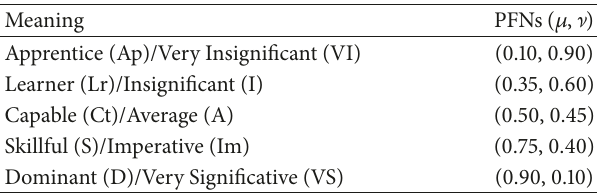
Table 1: Scale for evaluation of the preferences of DMs and